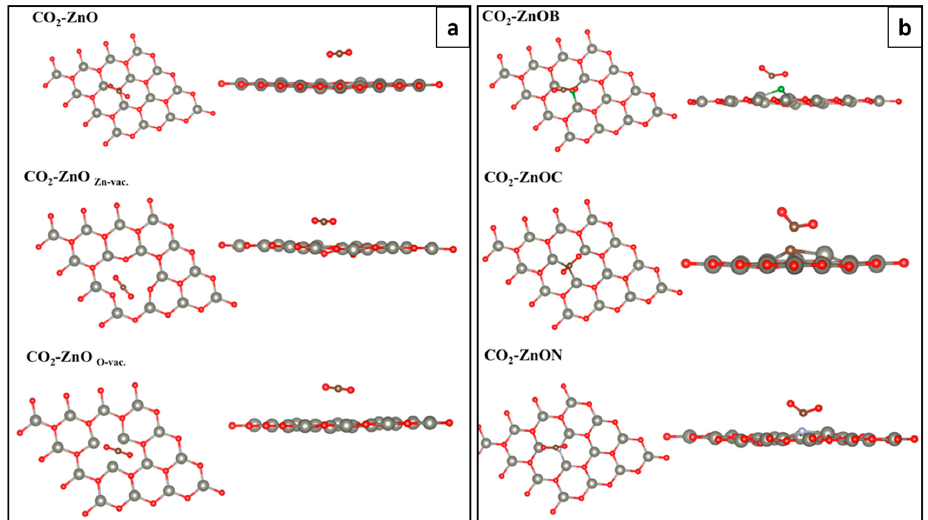
Figure 9. Adsorption of CO 2 on intrinsic, defect-bearing and doped graphene-like ZnO mono-layers. ( a ) From top to bottom, optimized structure of CO 2 adsorbed on a defect-free g-ZnO-ML, on a Zn vacancy and on an O vacancy, respectively. Grey, red and brown balls denote Zn, O and C atoms, respectively. ( b ) From top to bottom, optimized structure of CO 2 adsorbed on ZnOB, ZnOC and ZnON, respectively. Grey, red, green, brown and silver balls denote Zn, O, B, C and N atoms, respectively. Reprinted with permission from Reference [35]. Copyright © (2016) IOP Publishing Ltd.